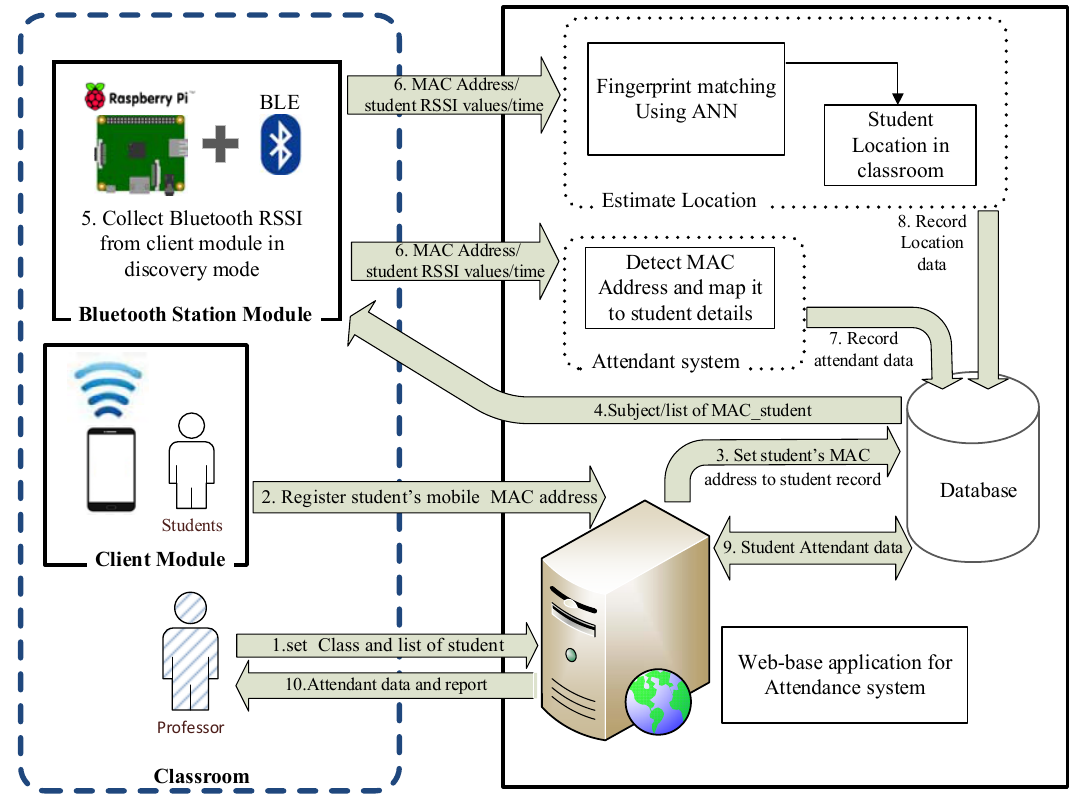
Figure 4. Attendance monitoring system.